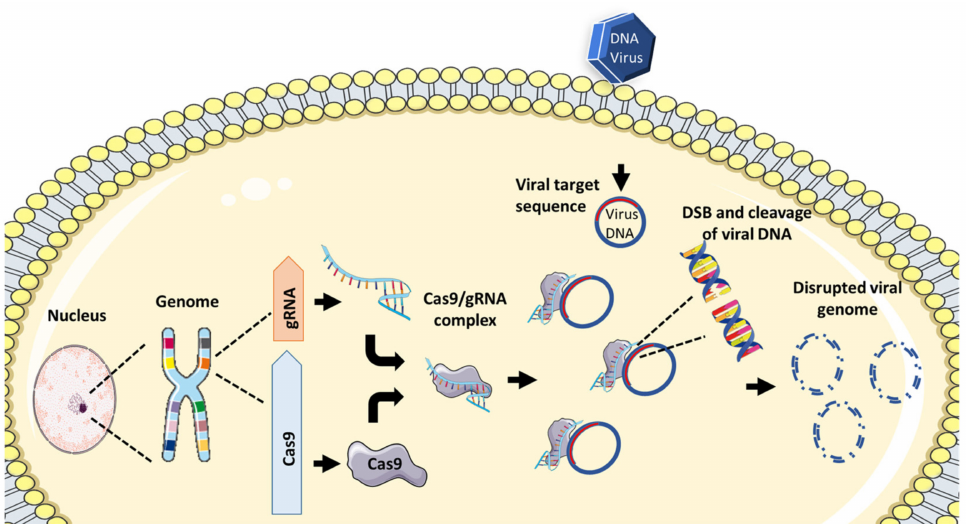
Figure 2. In vivo pathogen genome targeting: Cas9 and gRNAs (guide RNAs) targeting virus genomes are integrated into the host genome via genome editors or transposon systems. Cas9 and gRNAs are expressed and form a gRNA-Cas9 duplex. The gRNAs target the complementary DNA of the virus genome, and Cas9 induces a double-strand break (DSB) blocking viral replication.